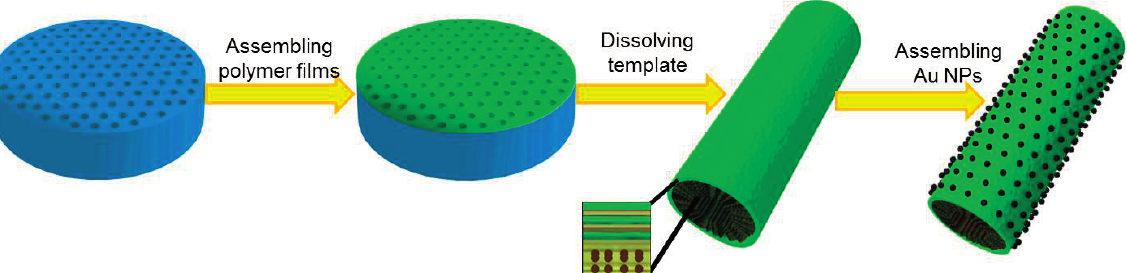
Figure 1. Schematic illustration of the fabrication of Au NPs-(PGA/SPI) micro-tubes. The blue porous pie represents the template for deposition of components. The brown dots and the colorful bands inside the micro-tube represent magnetic nanoparticles and (poly- L -glutamic acid) (PGA)/soybean protein isolate (SPI) multilayers, and the black dots on the outer surfaces of the micro-tubes represent the Au